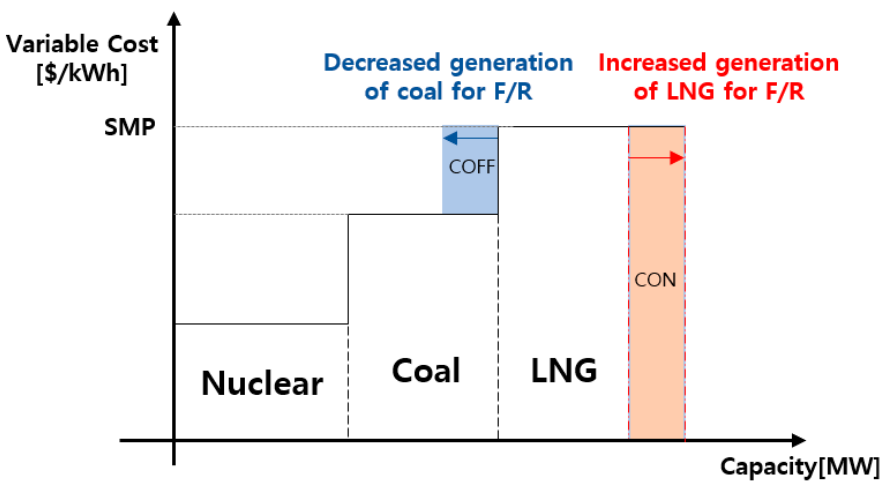
Figure 1. Economic benefits of ESSs for F / R in the electricity market [25,26].